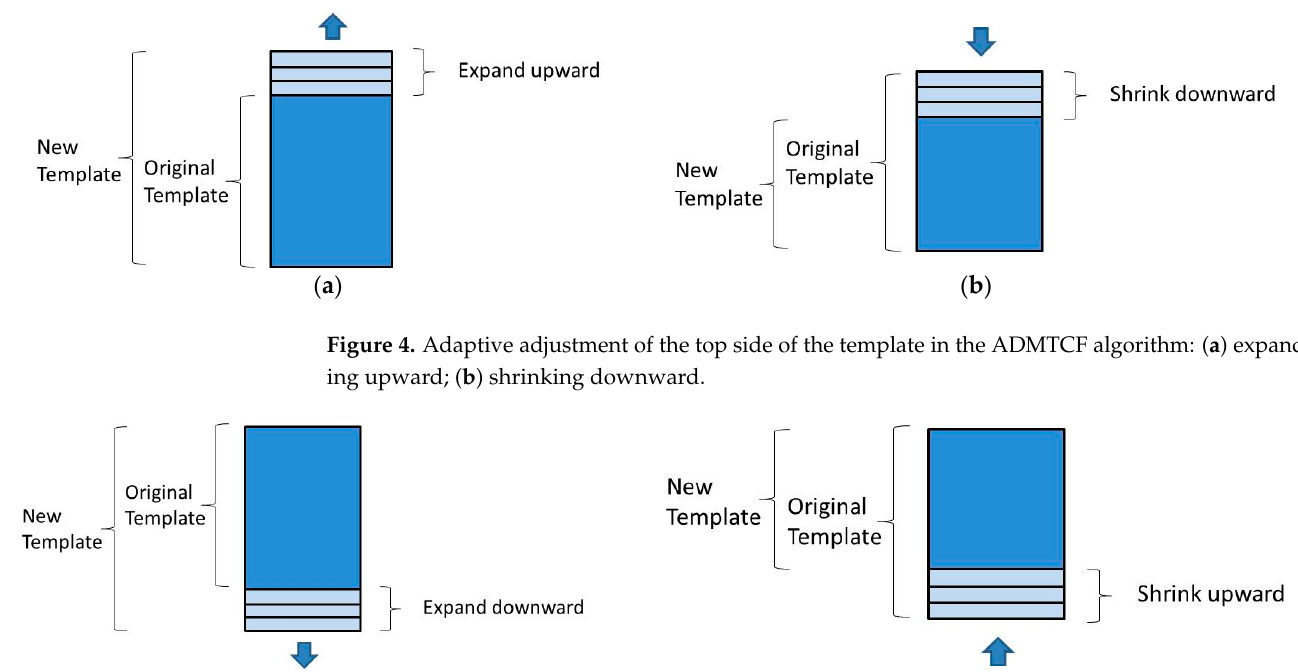
Figure 4. Adaptive adjustment of the top side of the template in the ADMTCF algorithm: ( a ) ex- panding upward; ( b ) shrinking downward.